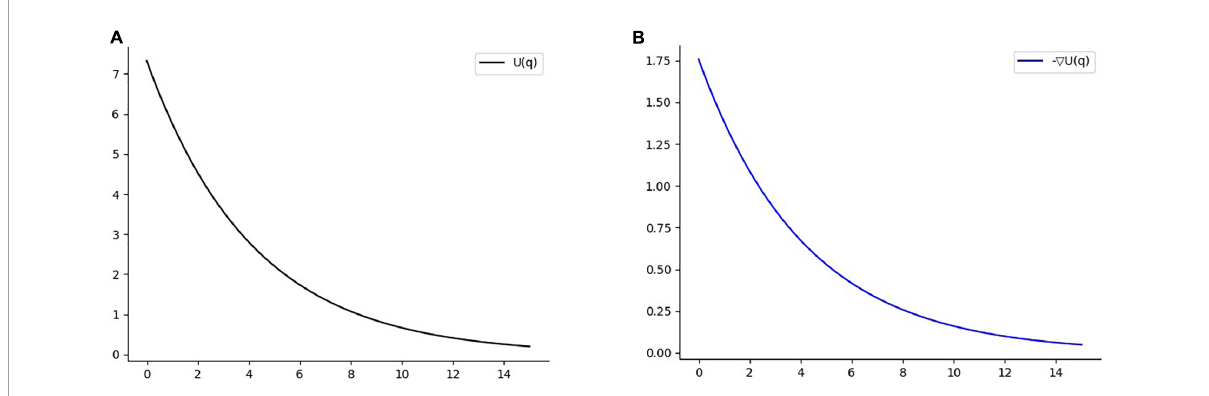
FIGURE7 (A) Function diagram of repulsion field. (B) Negative gradient function diagram of repulsion potential